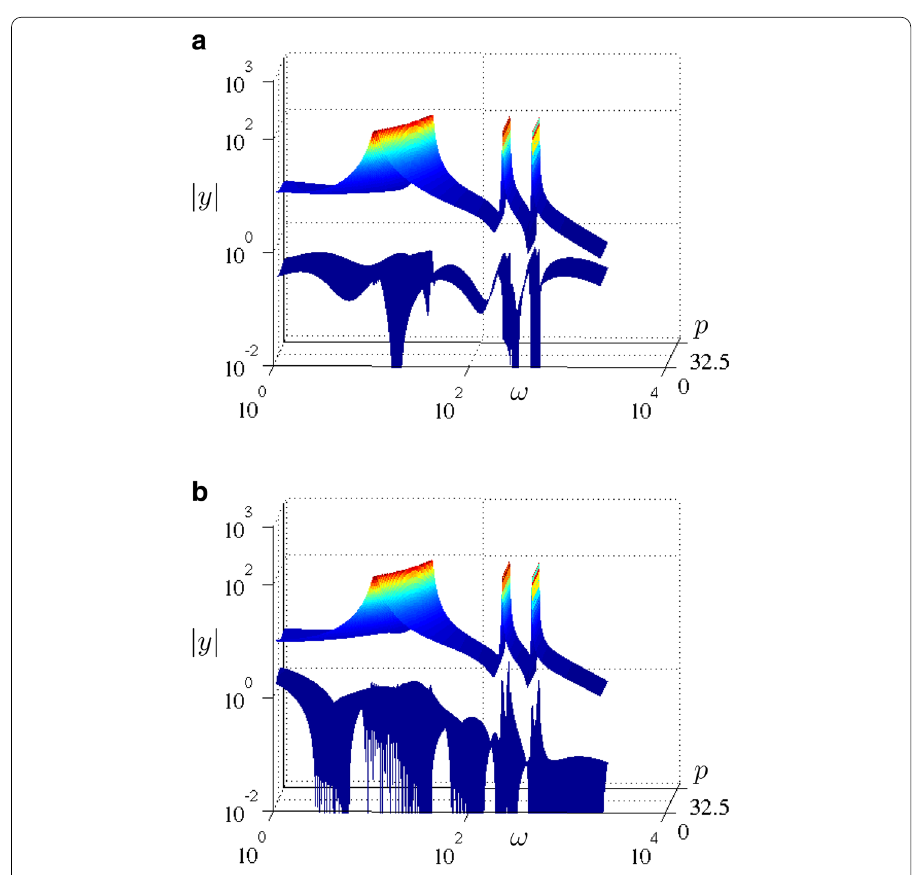
Fig. 11 Interpolation of ROMs of the same type: response surface and the absolute error. a Interpolation of BT ROMs. b Interpolation of ssest ROMs